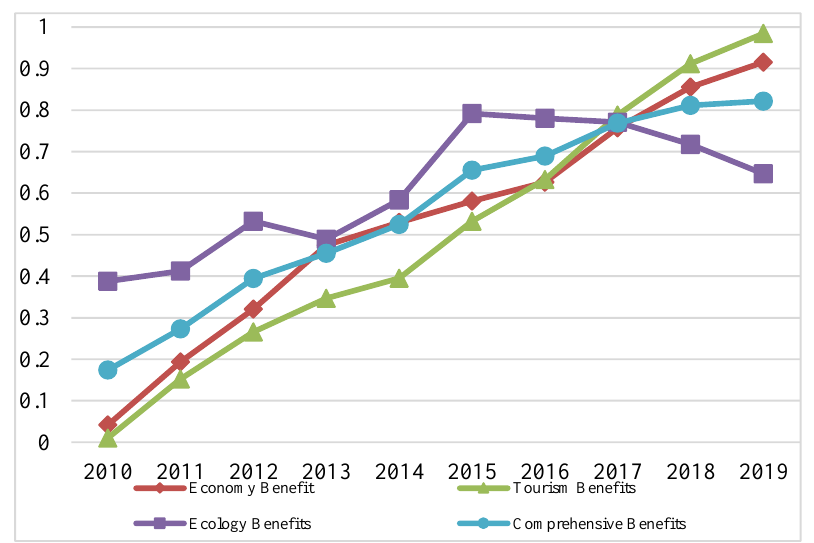
Figure 4. The comprehensive benefits of each subsystem and the TEE system in the PRD.